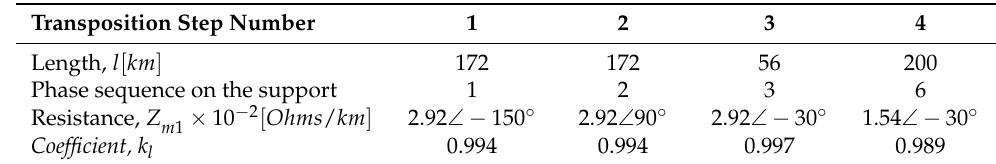
Table 6. The values of the line parameters at the lengths of the transposition steps selected according to the developed method Equations (1) and